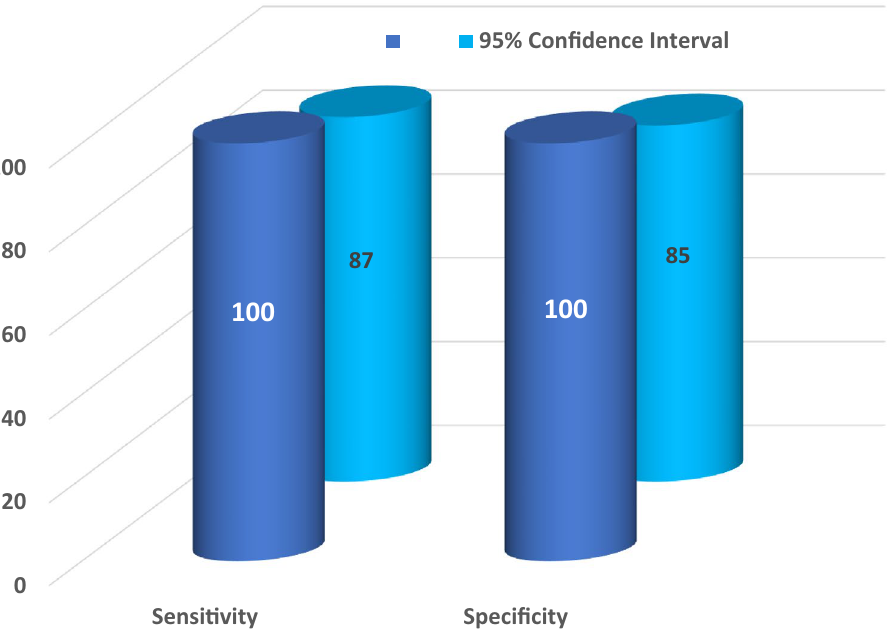
Figure 4. The sensitivity and specificity of the skin fibroblast-based Morphometric Imaging assay and the 95% confidence